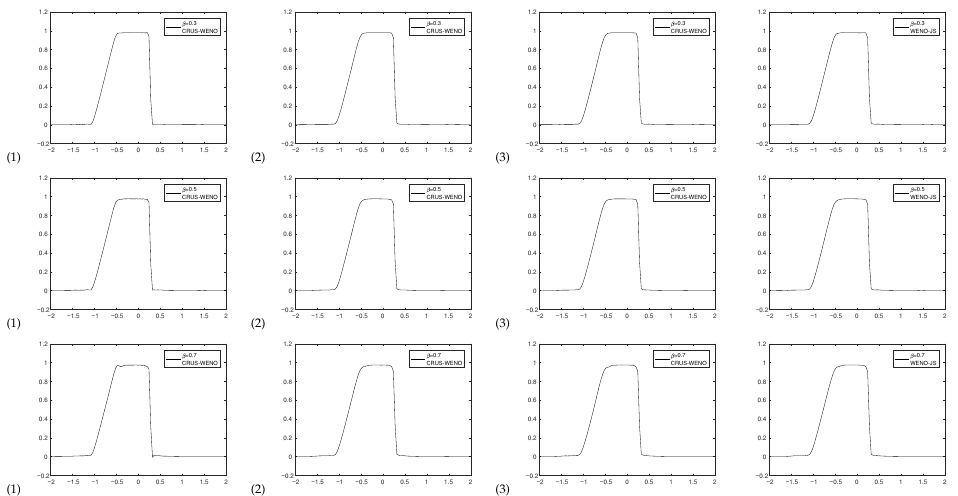
Figure 1. Example 4: Numerical solutions of the CRUS-WENO scheme with different linear weights ( 1 )–( 3 ) and the WENO-JS scheme at t = 0.5.